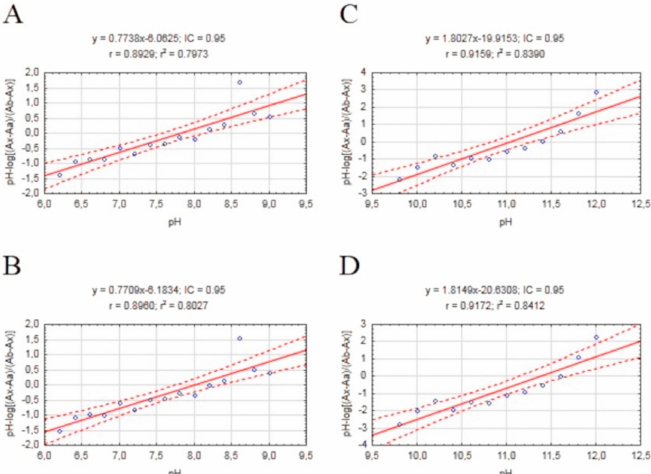
Figure 4. Scatterplots of mathematical formula results obtained for our compound with a regression equation. ( A ) Plot pH vs. pH-log(A x − A a ) / (A b − A x ) 310 / 336 nm; ( B ) Plot pH vs. pH-log(A x − A a ) / (A b − A x ) 336 / 310 nm; ( C ) Plot pH vs. pH-log(A x − A a ) / (A b − A x ) 310 / 336 nm; ( D )